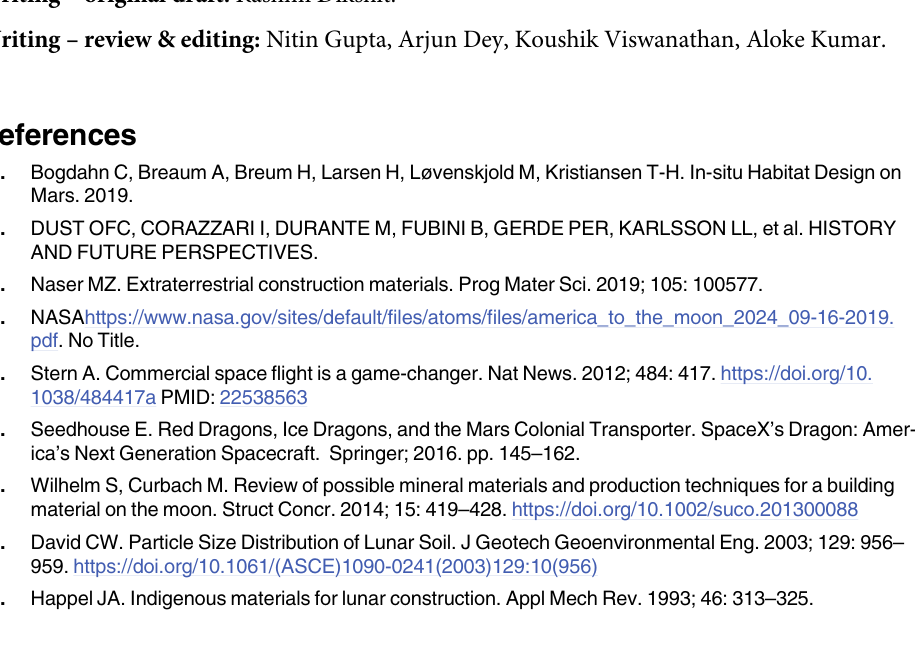
in flask condition and with soil separately 2